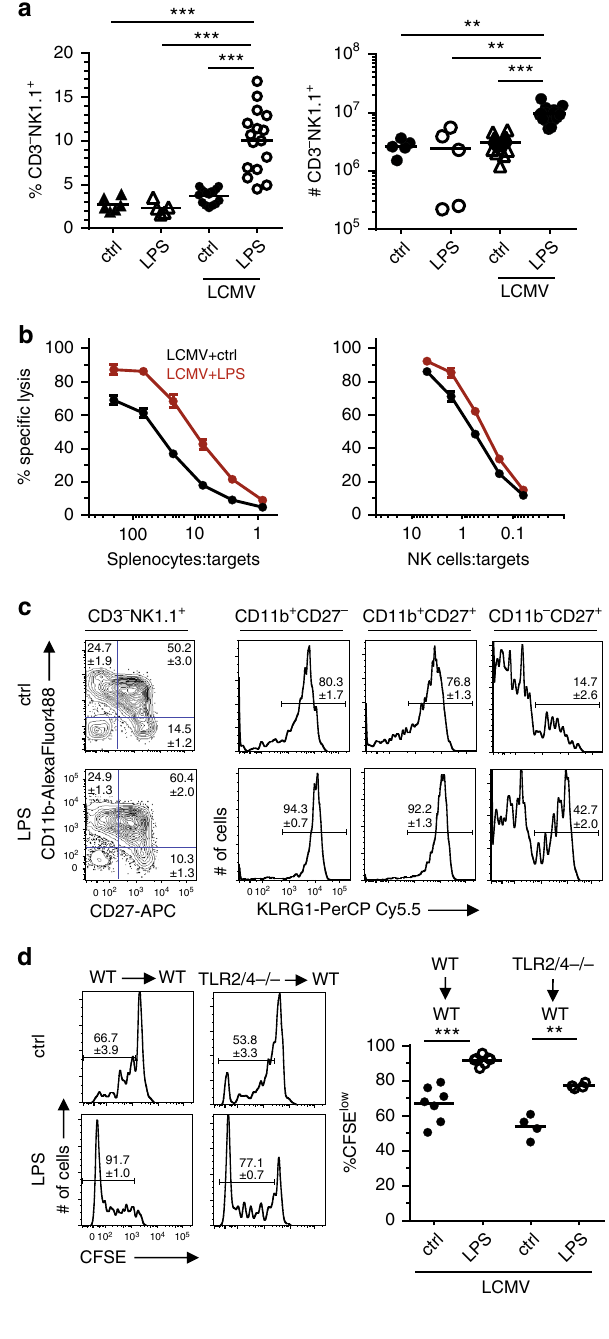
IFN- β , IL-2 and IL-18 have also been shown to be necessary and suf fi cient for NK cell activation following exposure to E. coli